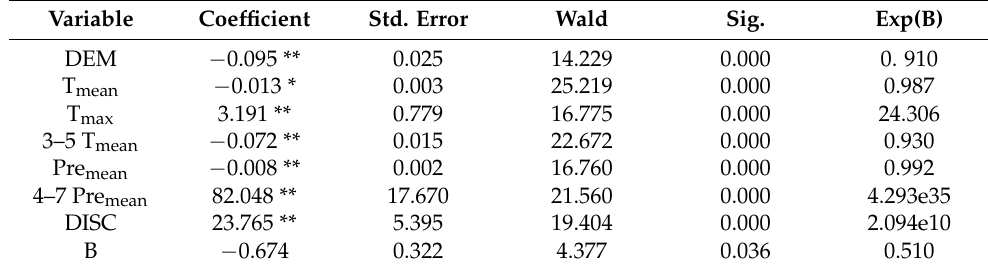
Table 4. Logistic regression results of the driving factors for the changes in S.